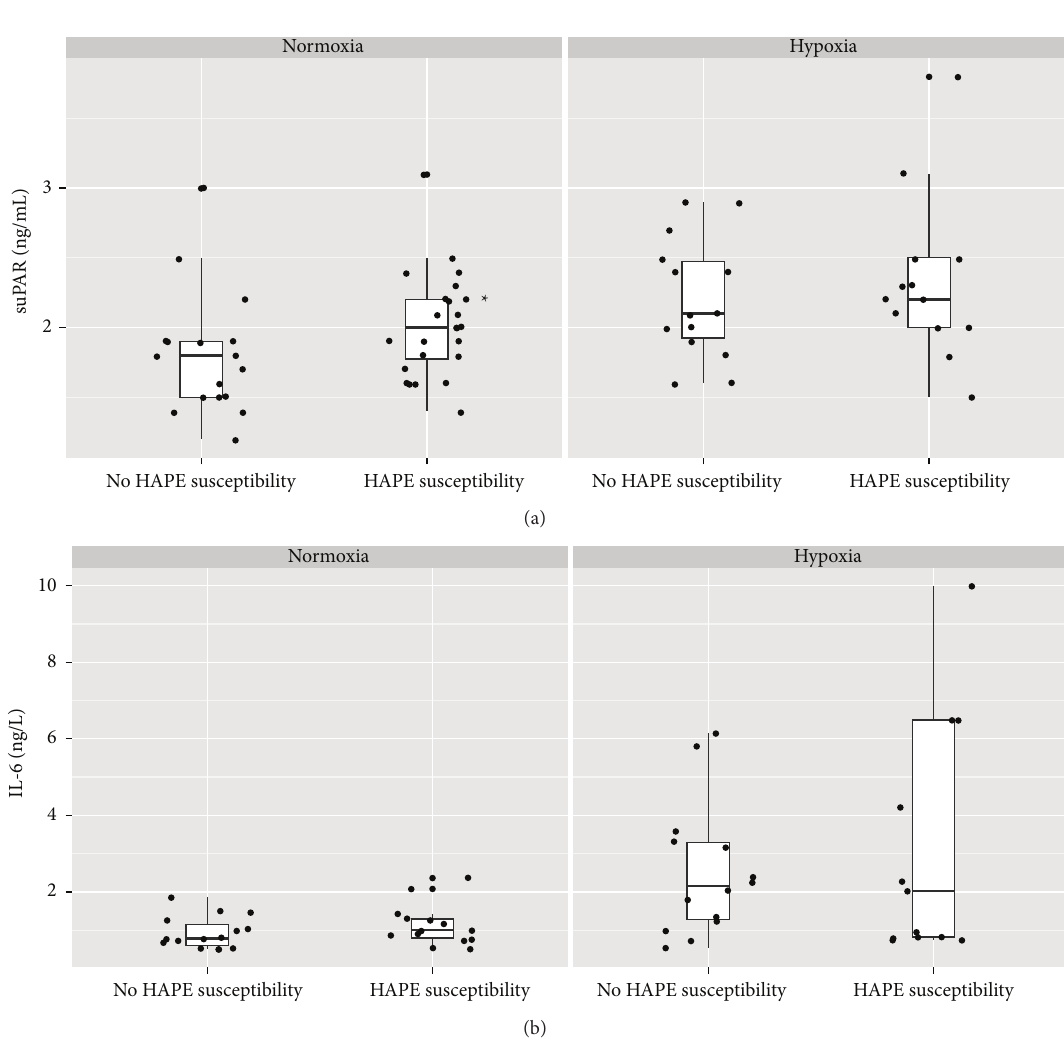
twice as severe in subjects assigned to the “AMS” group due to manifested AMS as compared to the control group (Table